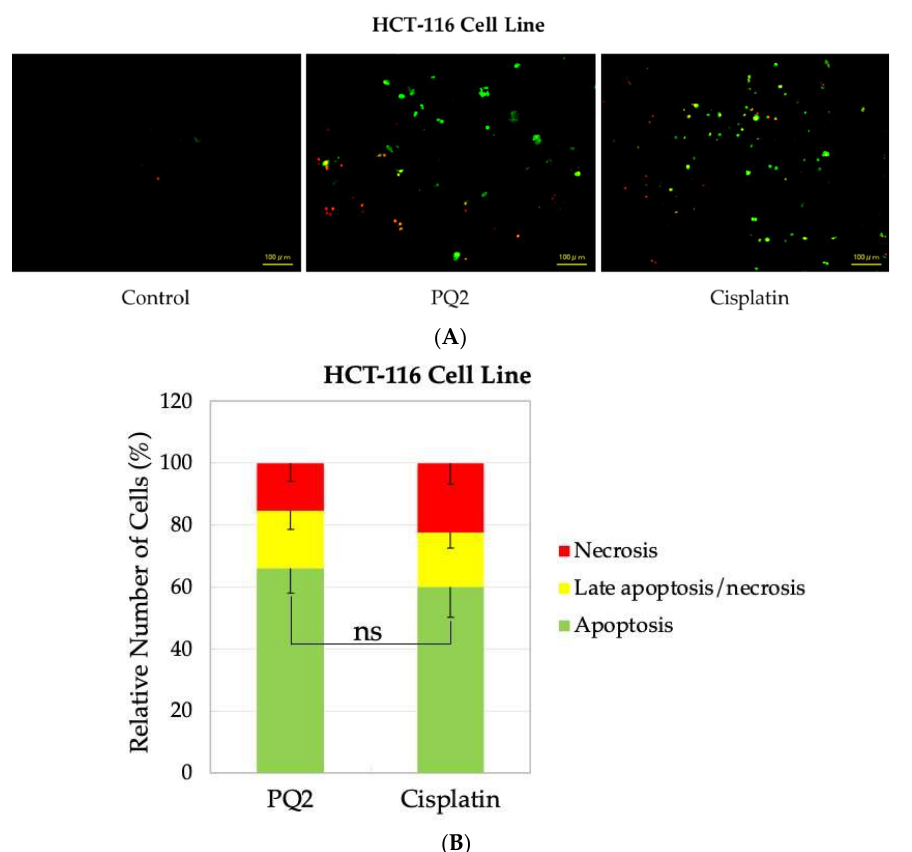
18% and 22%, respectively) at 12 h (Figure 9B). This outcome pointed out that PQ2 signif- icantly enhanced apoptosis in HCT-116 cells.